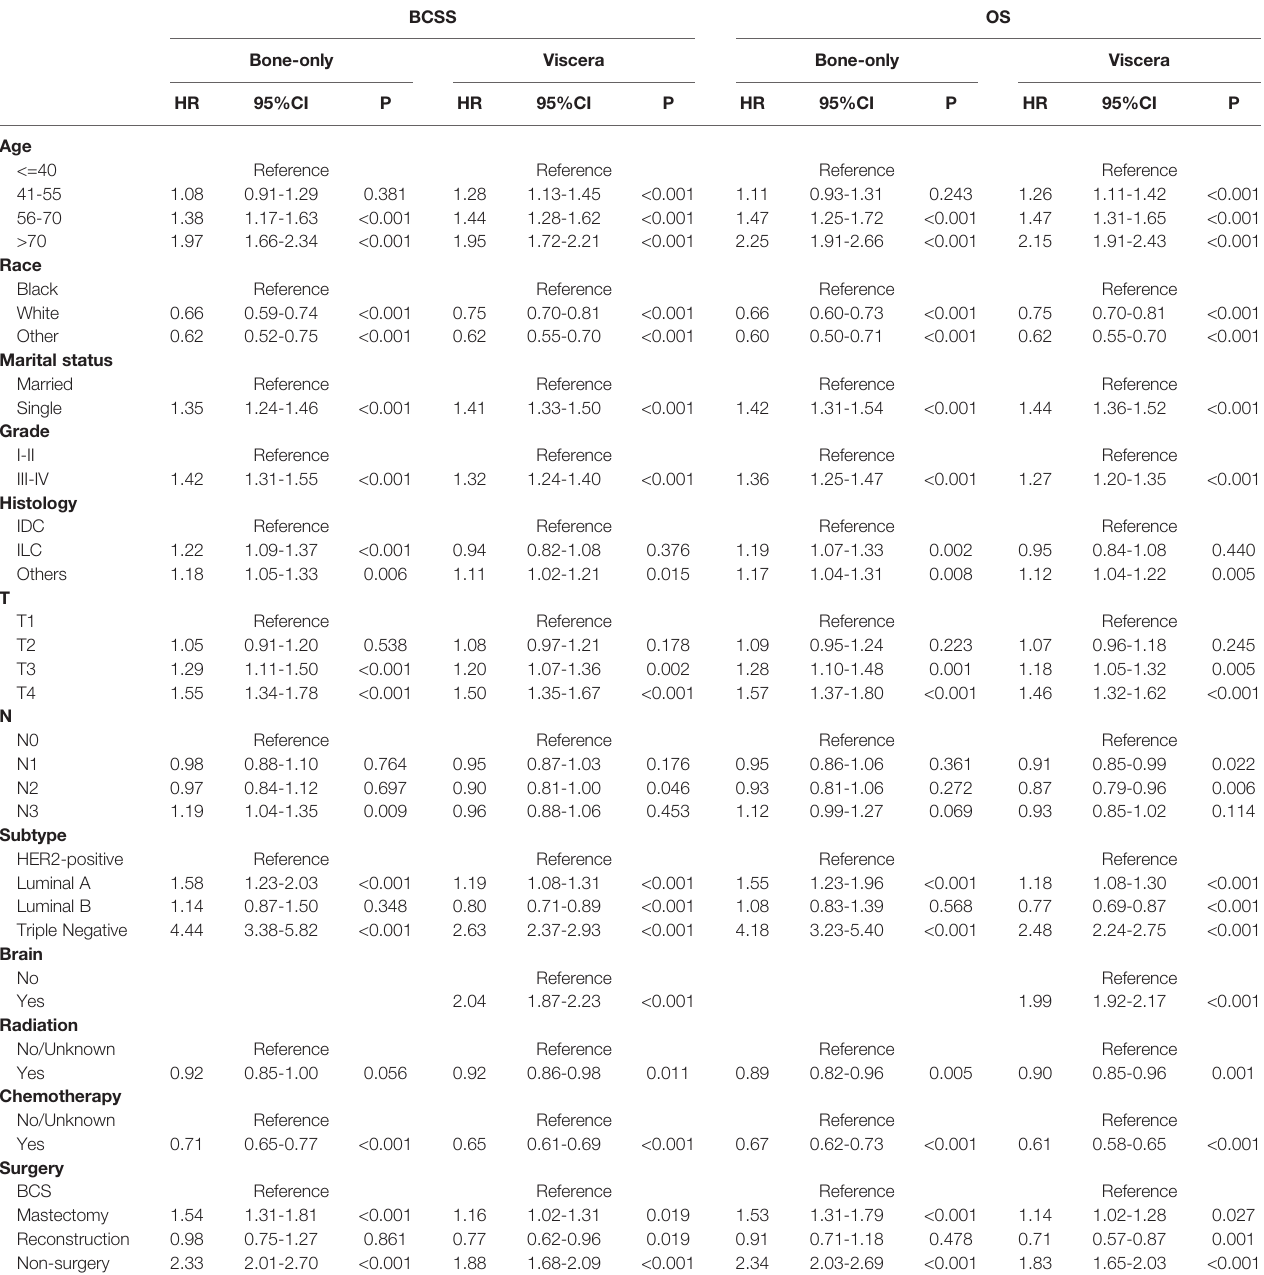
TABLE 3 | Univariate analysis of different metastatic patterns. BCSS OS Viscera